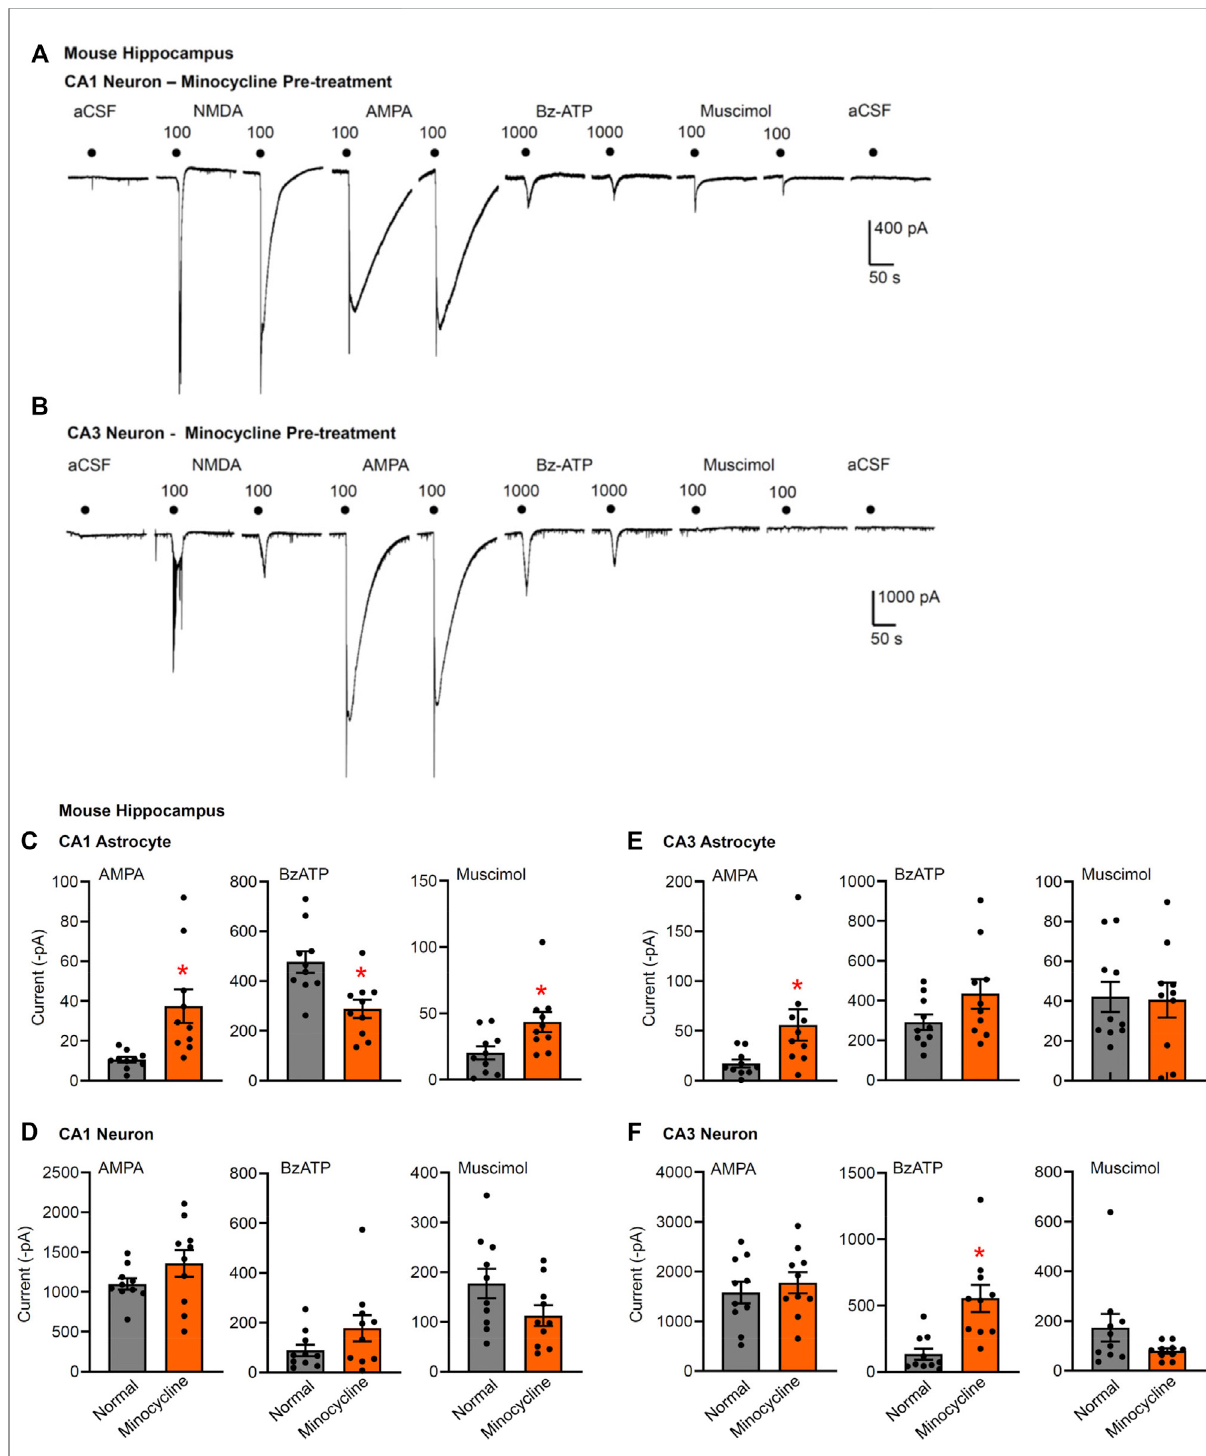
FIGURE 4 Current responses to ionotropic receptor agonists in the CA1 and CA3 areas of the mouse hippocampus. Hippocampal brain slices of 10 – 15 day-old wild-type mice without or with pre-treatment with minocycline (40 mg/kg, i.p. 3 days before the preparation of the slices). NMDA (100 µM), AMPA (100 µM), Bz-ATP (1,000 µM), muscimol (100 µM), and an equivalent amount of solvent (low X 2+ -containing aCSF) were locally superfused every 3 min, each agonist twice. The membrane currents were recorded in astrocytes by means of the whole-cell patch-clamp method at a holding potential of − 80 mV, and in neurons at a holding potential of − 70 mV. Representative tracings in neurons (A,B) . (C – F) Mean ± SEMcurrentamplitudes. (C) EffectsofAMPA,Bz-ATP,andmuscimolinCA1astrocytesofthethreetypesofanimals.* p < 0.05;statisticallysigni fi